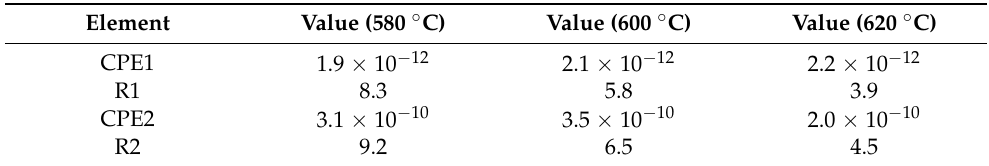
Figure 4. EIS plots for SrLa 2 Sc 2 O 7 composition obtained under dry air at 580, 600 and 620 °C. Table 3. Results of EIS plots fitting, where CPE is the constant phase element (F), and R is the Table 3. Results of EIS plots fitting, where CPE is the constant phase element (F), and R is the re- resistance (k Ω · cm). sistance (k Ω∙ cm).